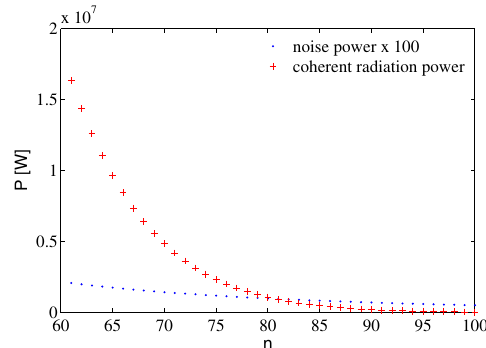
FIG. 3. Comparison of the radiation power of CHG (red cross) and the noise power (blue dot) from R 1 for different harmonic